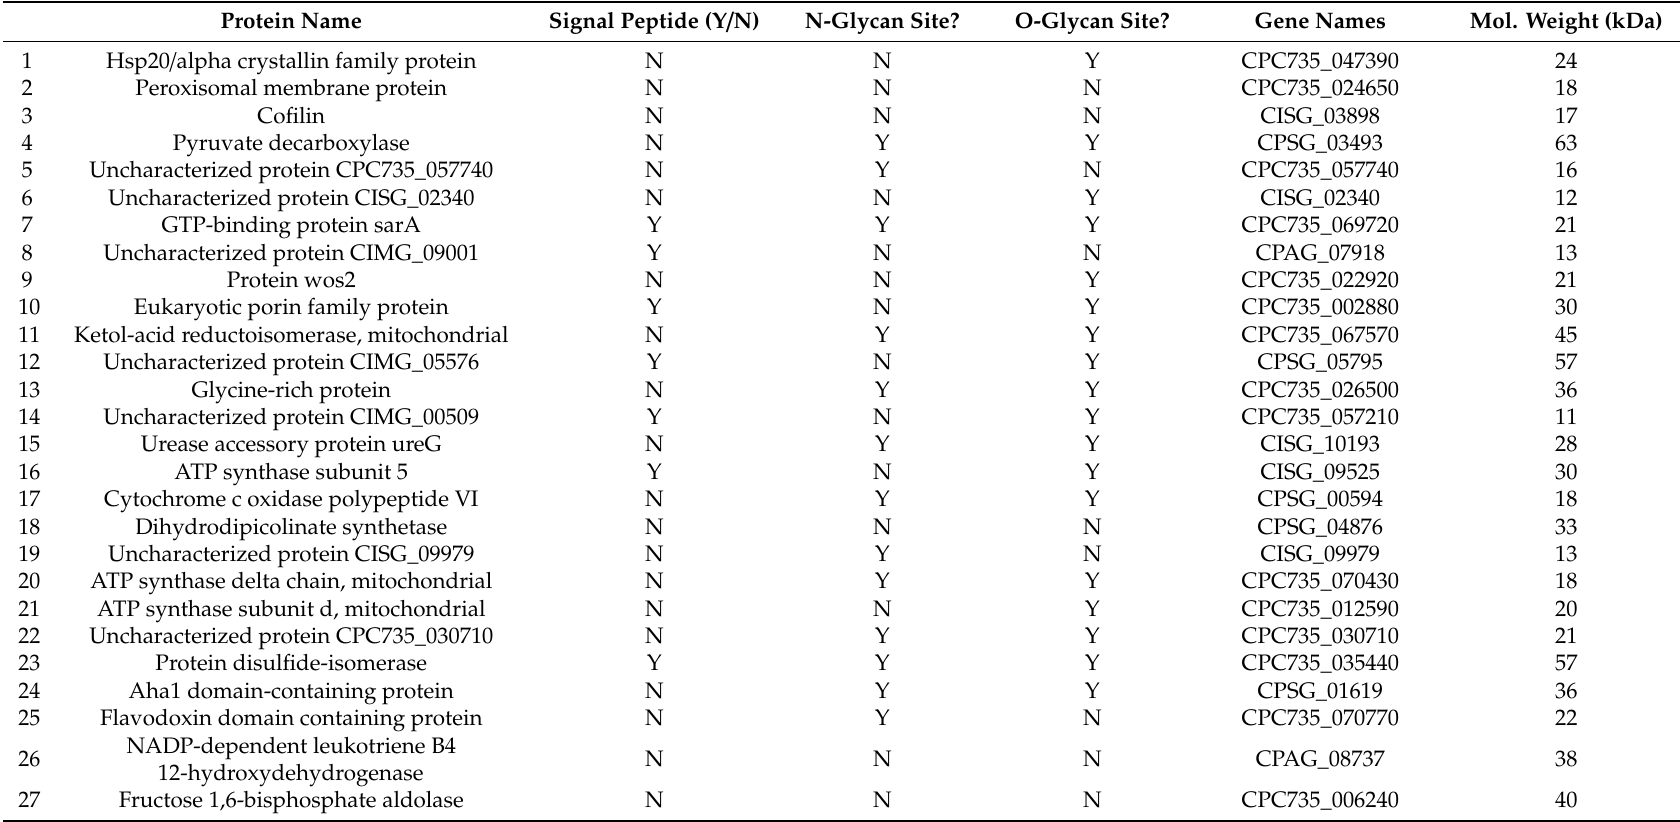
Table 1. Protein characteristics of the 27 biomarker candidates identified in this